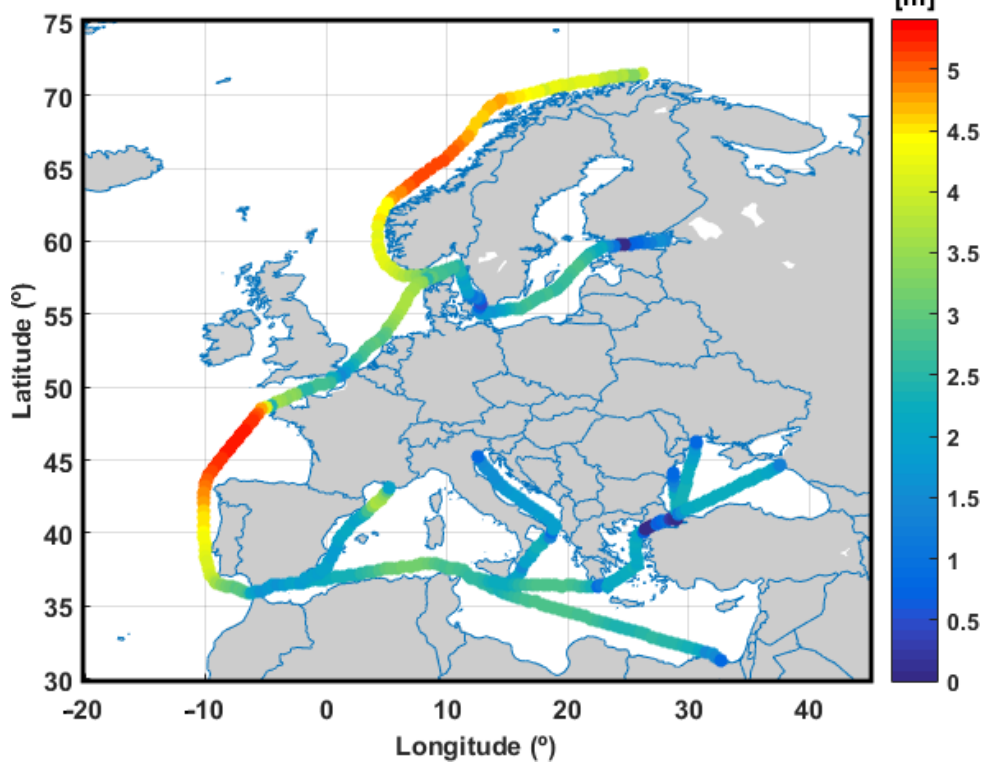
Figure 19. Hs 95th percentile along the European maritime routes. Table 5. Maximum Hs 95th percentile on each route considered in this study.